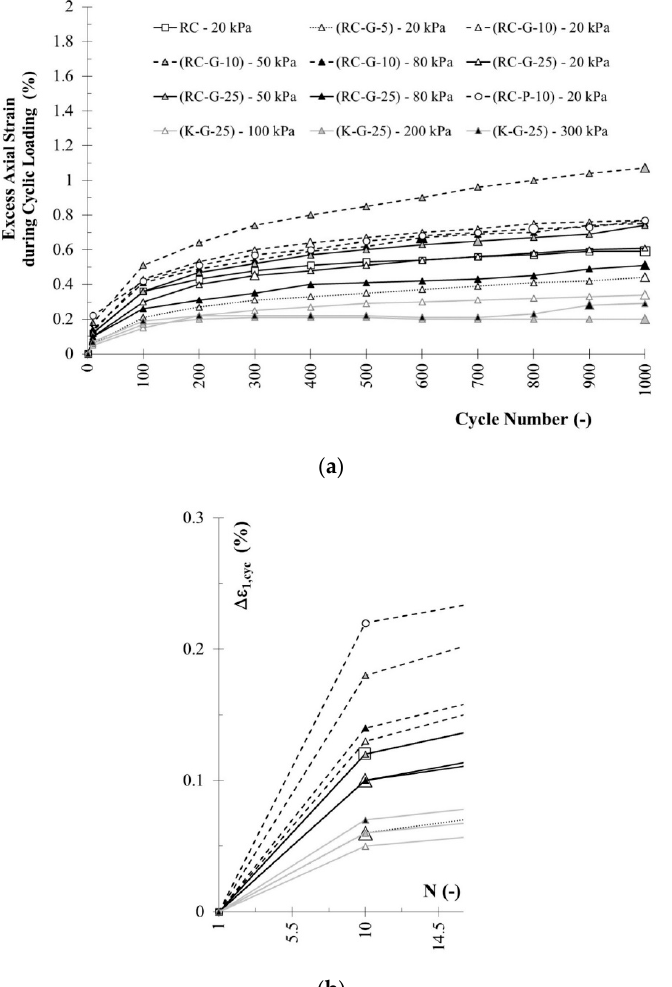
Figure 5. Axial strain variation ε 1,cyc with the cycle number from: ( a ) 1–1000 cycles; ( b ) 1–10 cycles.